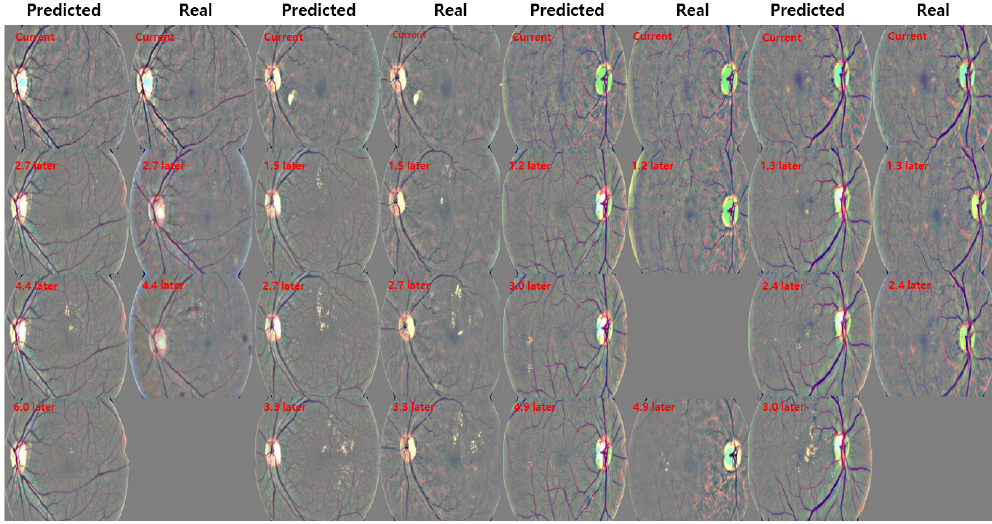
Figure 4. The sample results of predicted future fundus image produced with the regularization loss function. We can properly predict the progressions of different diseases from each patient over time and confirm them by synthesizing the future fundus image. The text label (e.g., 2.7 later) means a predicted future image after 2.7 years from the current input